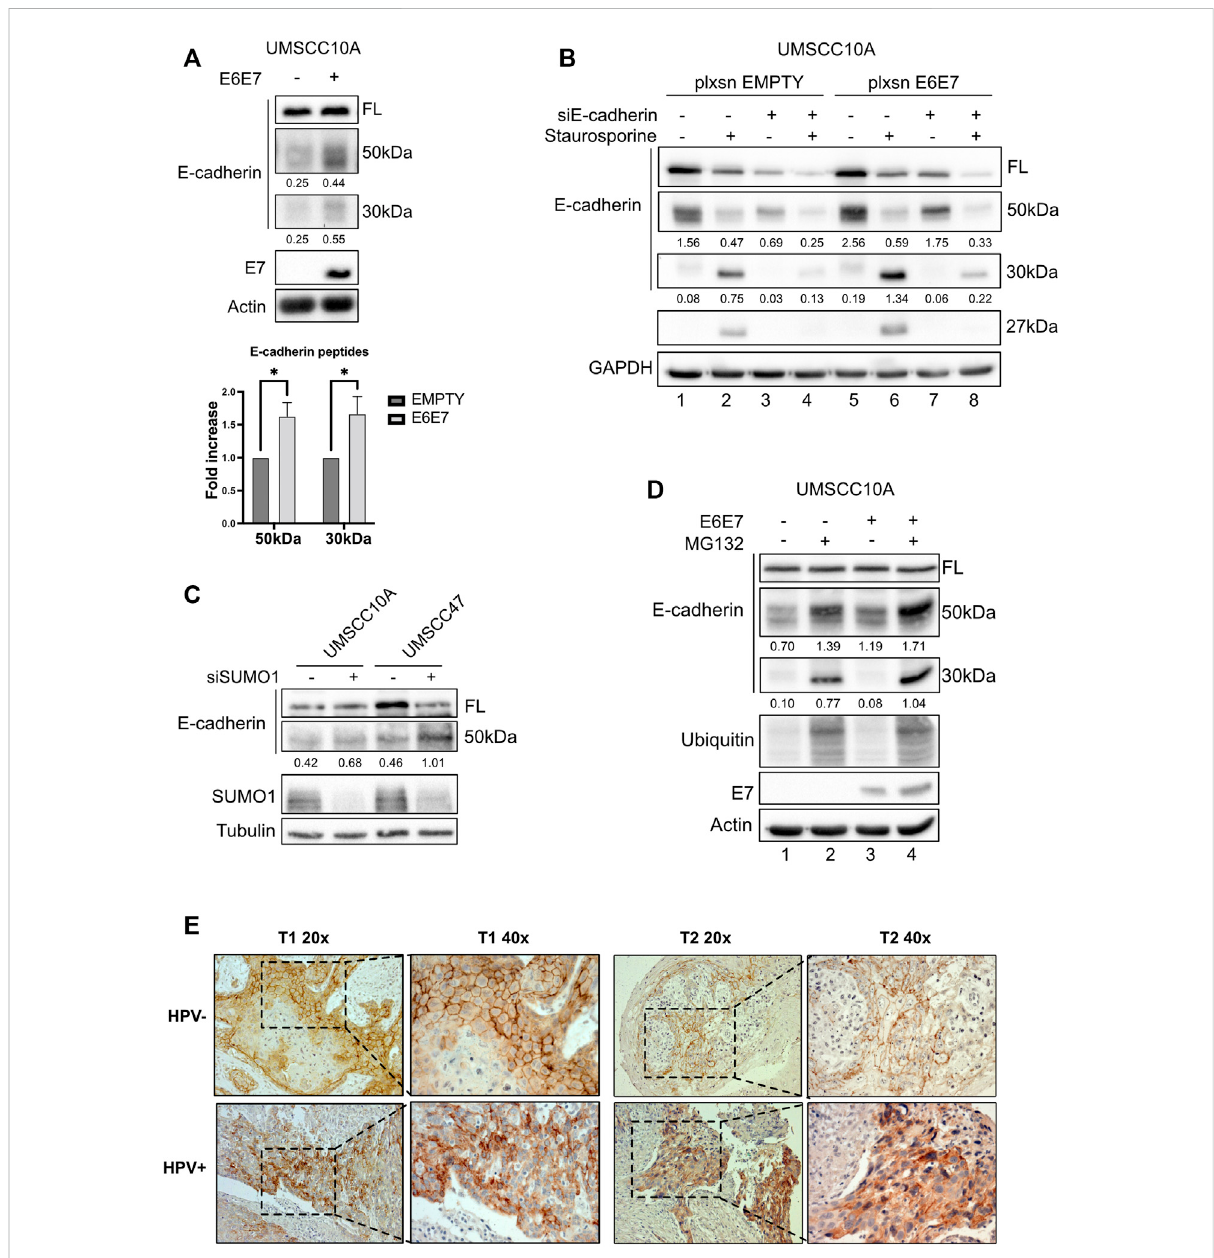
HPV16 and SUMO1 regulation of E-cadherin cleavage and localization. (A) UMSCC10A cells were transduced with empty or HPV16E6/ E7 recombinant retroviral vectors. Lysates were analyzed by immunoblotting with the indicated antibodies. Graph represented densitometric analysisandreportedasmeans±SEMoffoldchanges,*, p < 0.05(two-wayANOVAmultiplecomparisontest). n =7. (B) UMSCC10Acellstransduced with empty or HPV16E6/E7 recombinant retroviral vectors, were transfected with speci fi c siRNA against E-cadherin or Luciferase as control. 72 haftertransfection,cellsweretreatedornotfor6 hwith1 μ Mstaurosporine,lysedandanalyzedbyimmunoblottingwiththeindicatedantibodies (FL, full-length).Densitometric analysis was performed and opticaldensity values normalized to loading control were reported beloweachband. (C) HPV-positive HNC cell lines (UMSCC47) and HPV-negative (UMSCC10A) cell lines were transfected for 72 h with speci fi c siRNA against SUMO1 or Luciferase as control. Cells were then lysed and analyzed by immunoblotting with the indicated antibodies. (D) UMSCC10A cells were transduced with empty or HPV16E6/E7 recombinant retroviral vectors. Cells were then seeded and treated with 10 μ M MG132 for 16 h, lysed and analyzed by immunoblotting with the indicated antibodies. (E) Representative IHC images of FFPE from tumoral HN oropharyngeal HPV-positive or negative tissues, as indicated, stained with anti-E-cadherin antibody, presented at two different magni fi cations (40x and